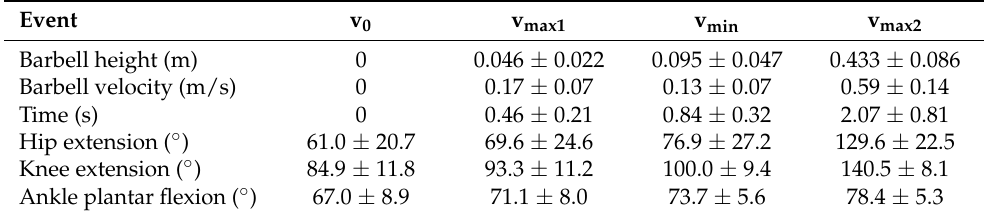
Table 1. Mean ( ± standard deviation) barbell kinematics and joint angles at the different events of the sticking region during the one-repetition maximum average for all participants